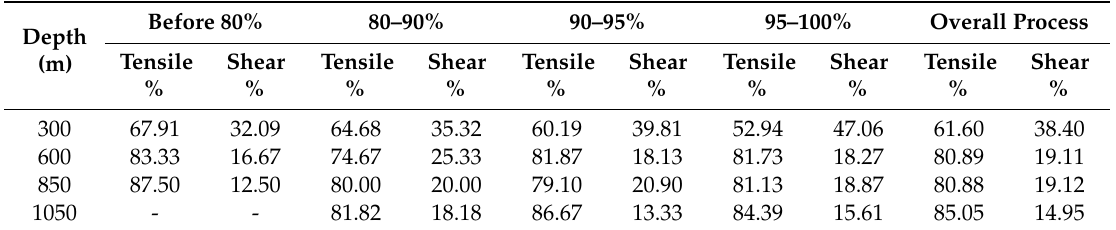
Table 2. Tensile crack percentage and shear crack percentage of coal samples at different depths.